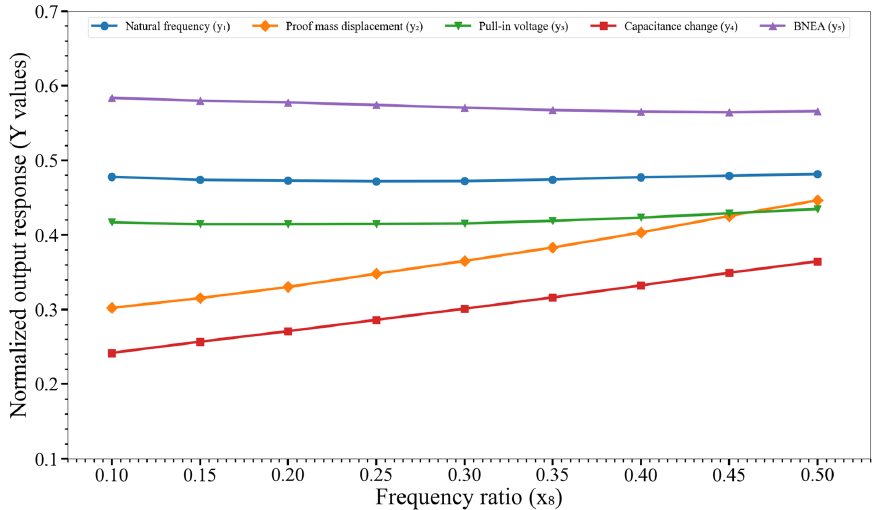
Figure 14. E ff ect of variation of the frequency ratio (x 8 ) on the output responses y 1 , y 2 , …, y 5 . Key. y 1 : natural frequency; y 2 : proof mass displacement; y 3 : pull-in voltage; y 4 : capacitance change; and y 5 : BNEA.